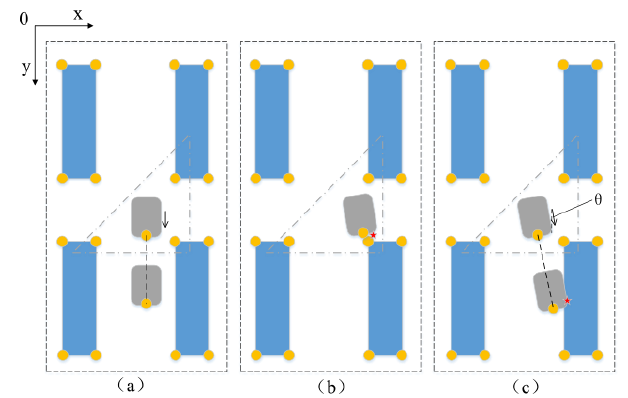
Figure 6. Different collision avoidance situations.